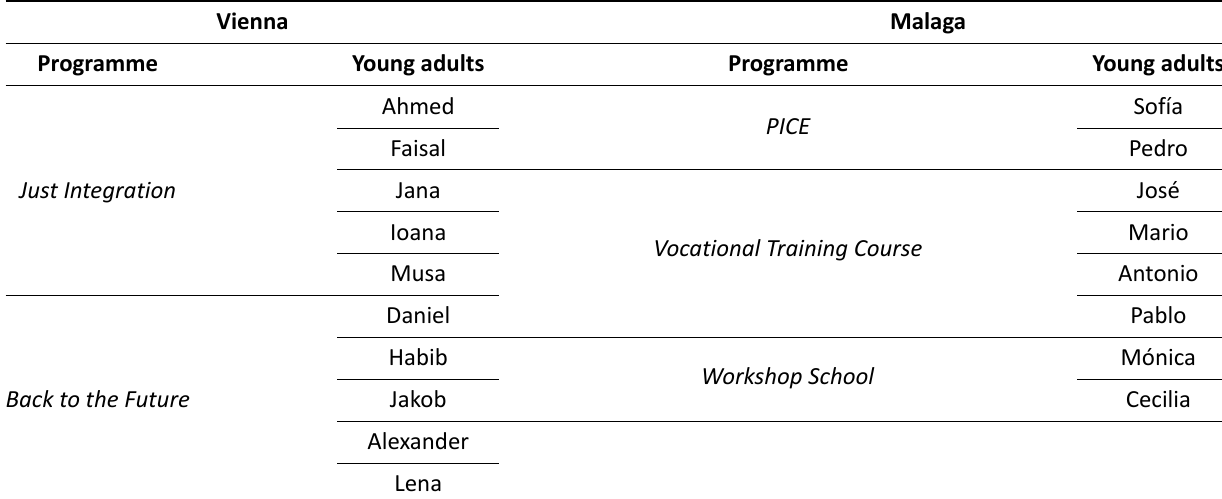
Table 1. Distribution of young adults (with fictitious names) in both regions, by programme in which they are